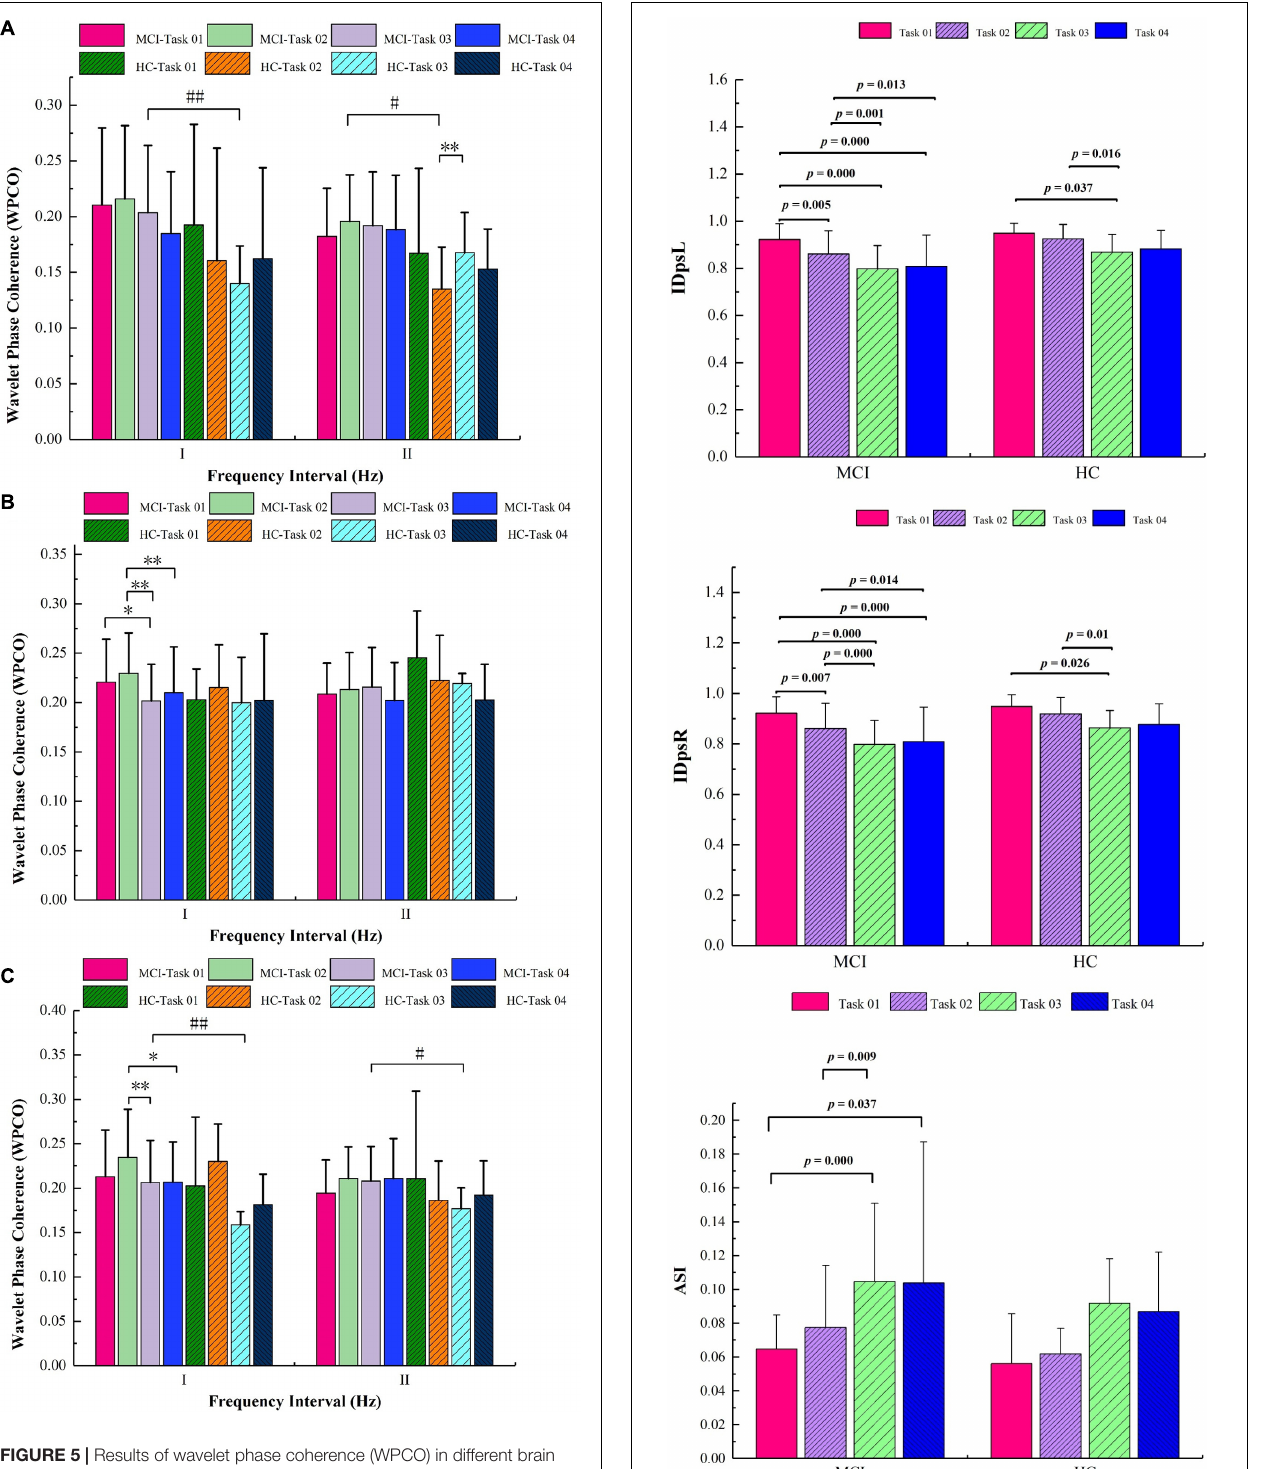
Frontiers in Aging Neuroscience |